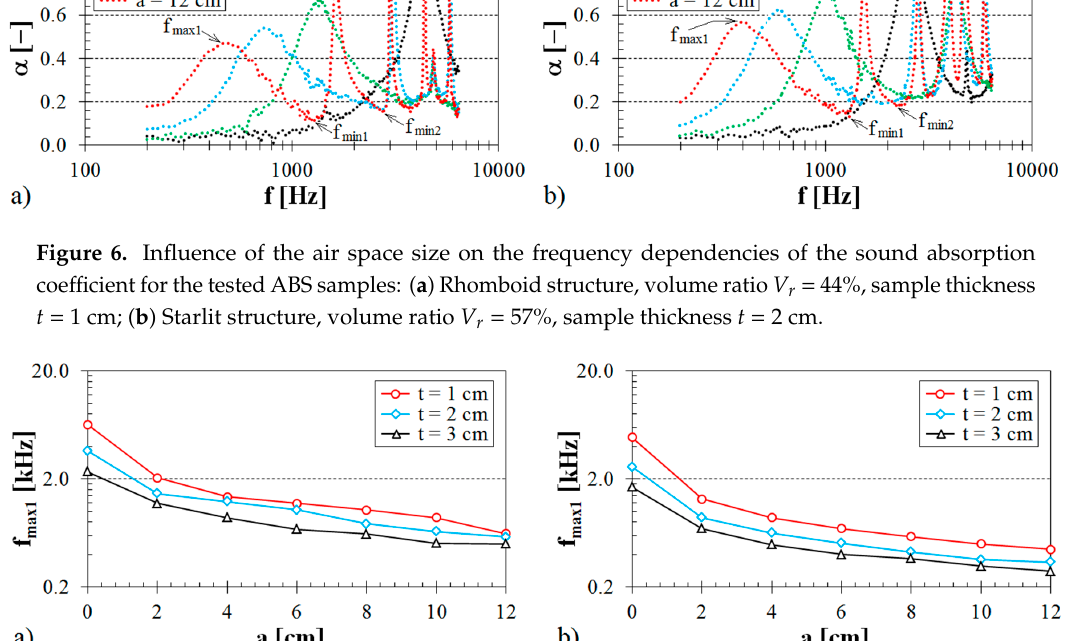
Figure 7. Dependencies of the primary sound absorption maxima on the air space size at various thicknesses of the tested ABS samples: ( a ) Rhomboid structure, volume ratio V r = 44%; ( b ) Octagonal structure, volume ratio V r = 70%.